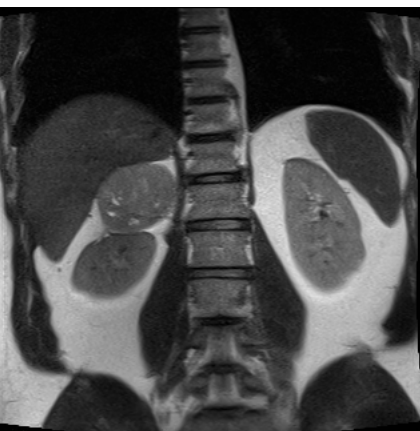
Figure 1: Coronal section of magnetic resonance imaging (MRI) showing 7.3cm right adrenal mass.